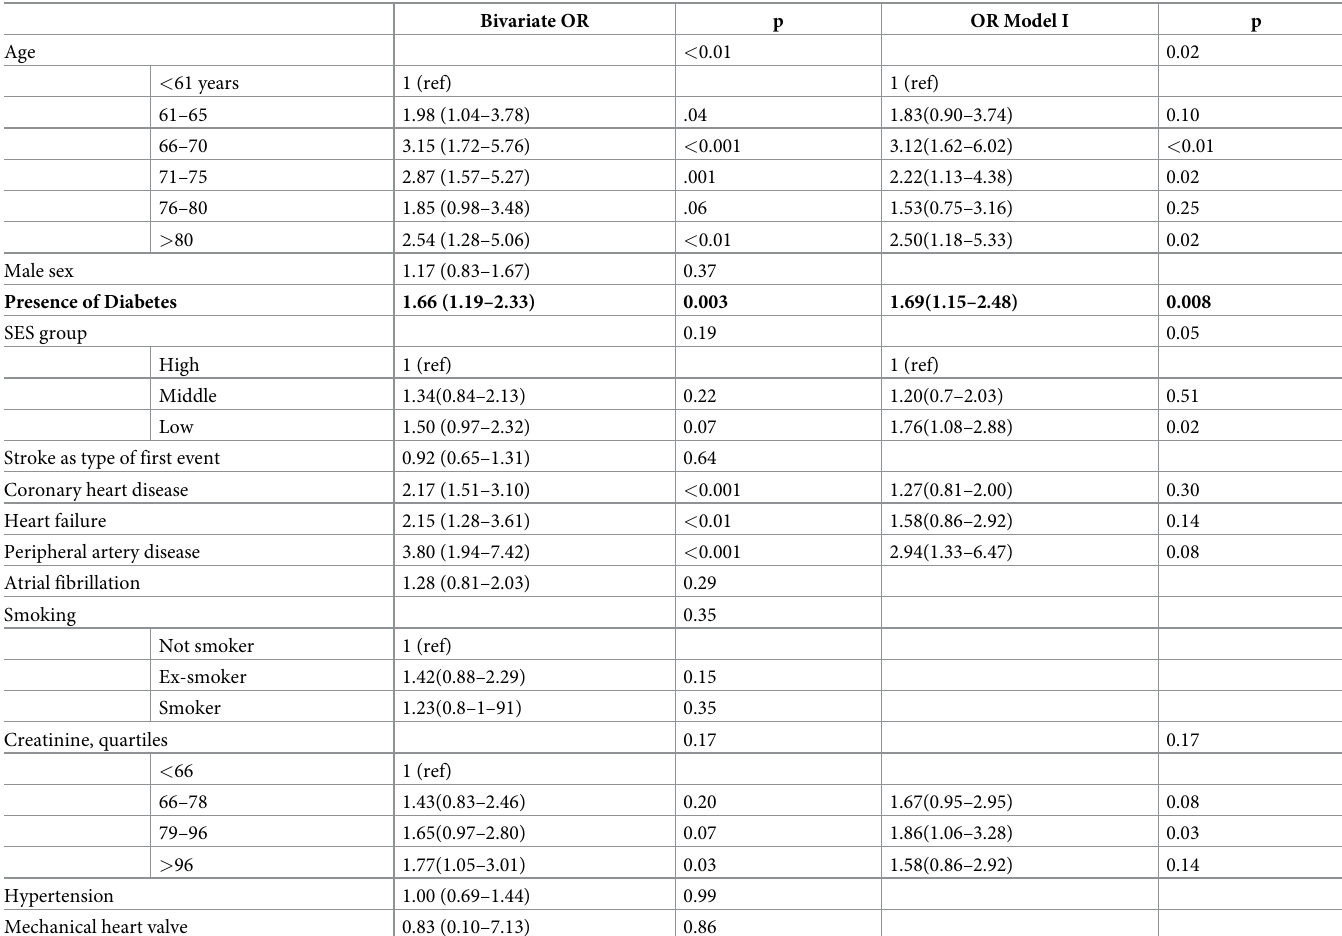
Table 5. Logistic regression in all subjects with presence of carotid stenosis as